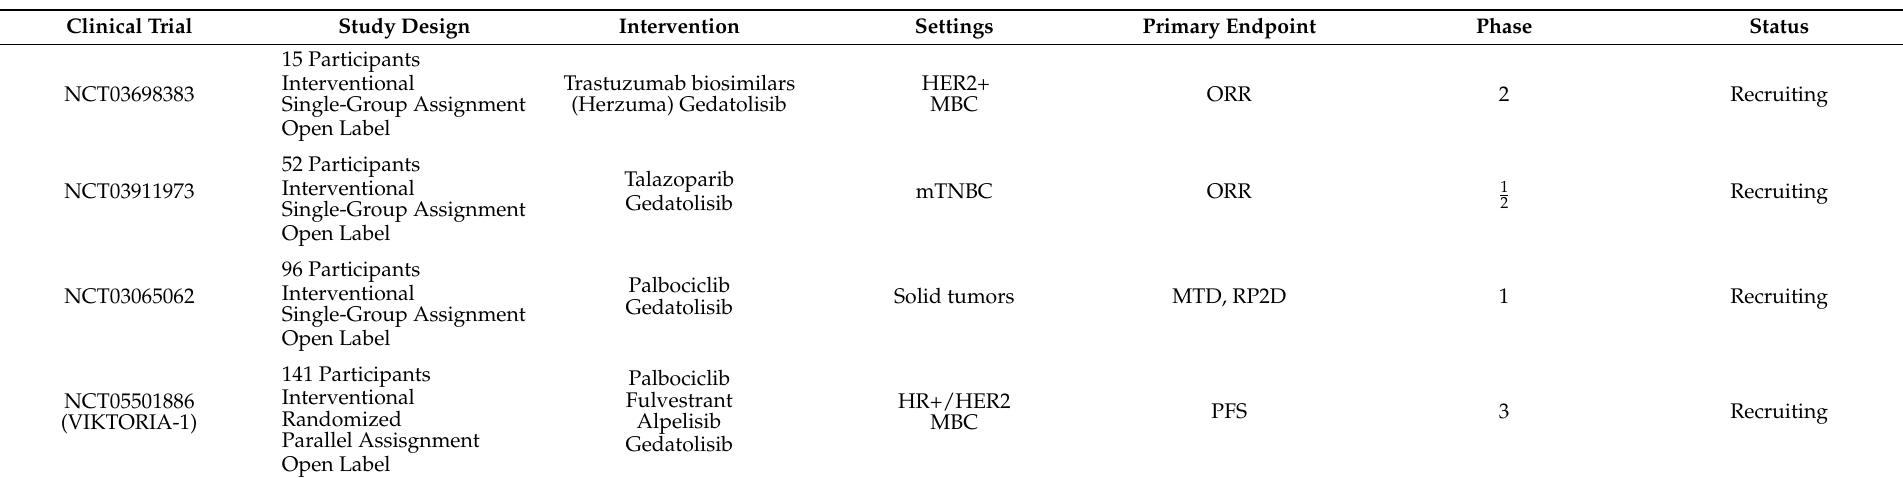
Table 3. Summary of ongoing phases II-III trials with dual PI3K/mTOR